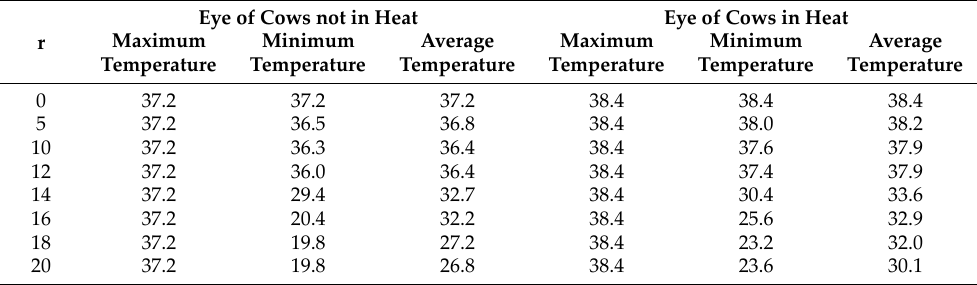
Table 2. Data table of maximum, minimum and average eye temperatures of anestrous and estrous cows with different profiles.